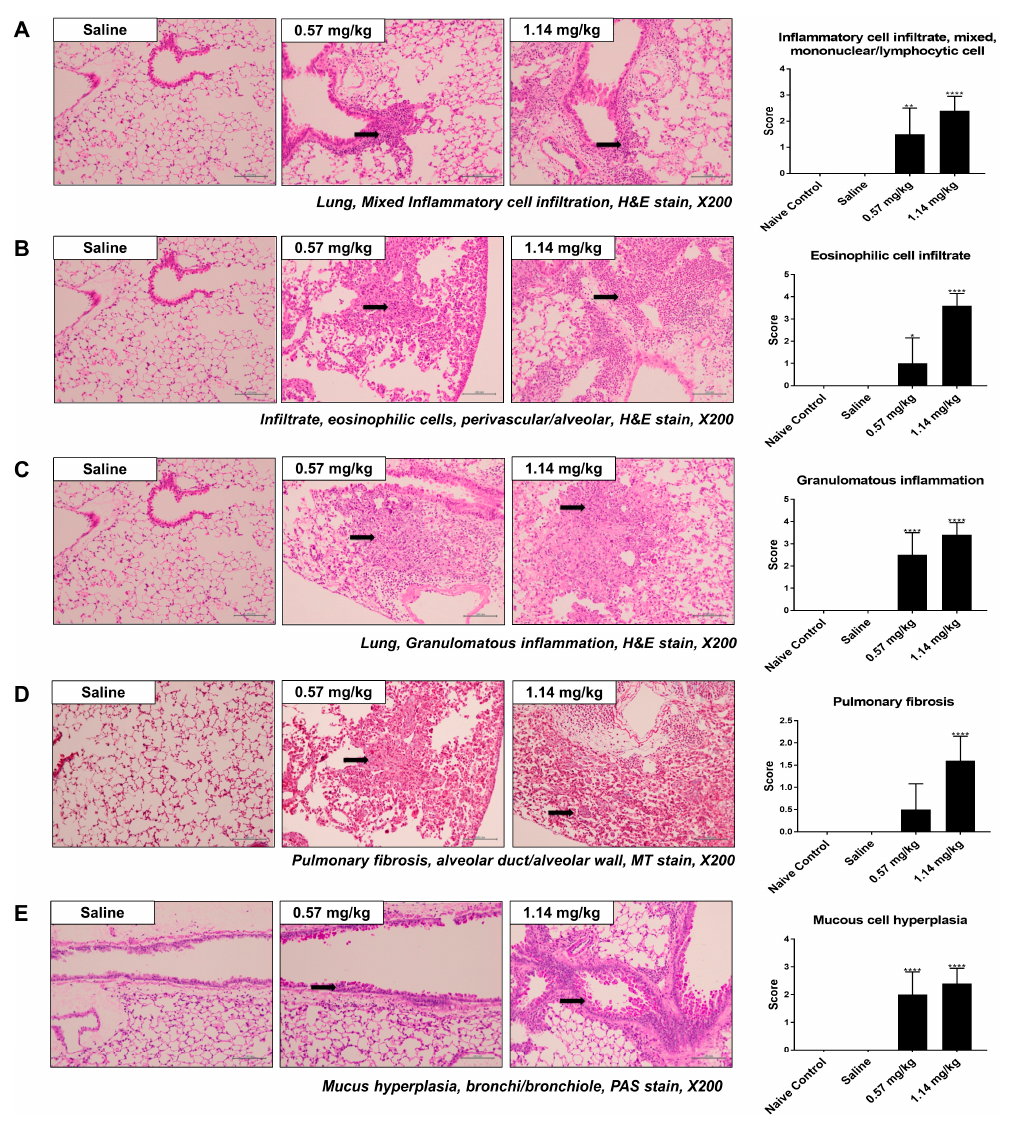
Figure 2. Histopathological analysis of lung tissues from control and Kathon-exposed mice. Representative hematoxylin and eosin (H&E)-stained lung sections and inflammation scores of mixed inflammatory cell infiltration ( A ), eosinophilic cell infiltration ( B ), and granulomatous inflammation ( C ). Masson’s trichrome (MT)-stained sections of lung and pulmonary fibrosis ( D ). Representative periodic acid–Schiff (PAS)-stained lung sections and mucus cell hyperplasia scores ( E ). Black arrows indicate inflammatory cells, collagen, and goblet cell deposition. * p < 0.05, ** p < 0.01, and **** p < 0.0001 vs. saline.